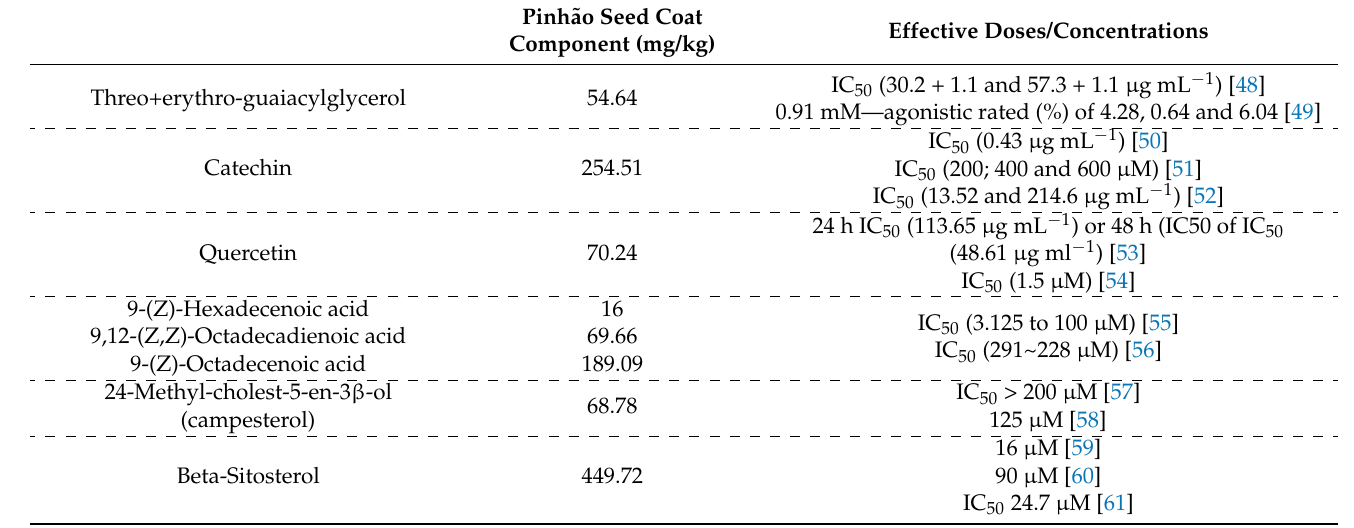
Table 1. Pinh ã o seed coat component in mg/kg and effective doses in cell lines, reference of values obtained from a previous work